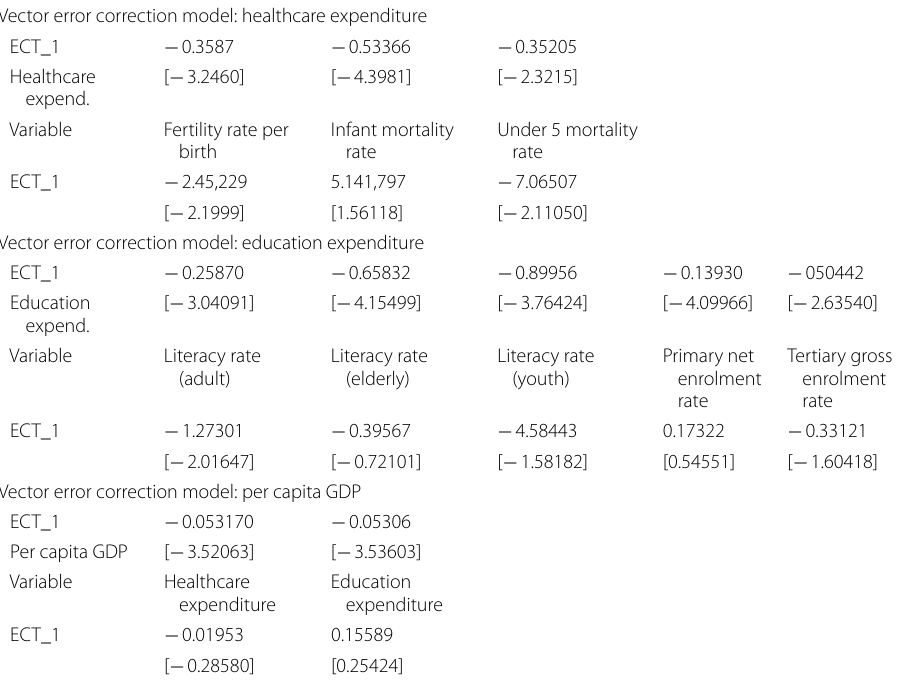
Table 6 Vector error correction